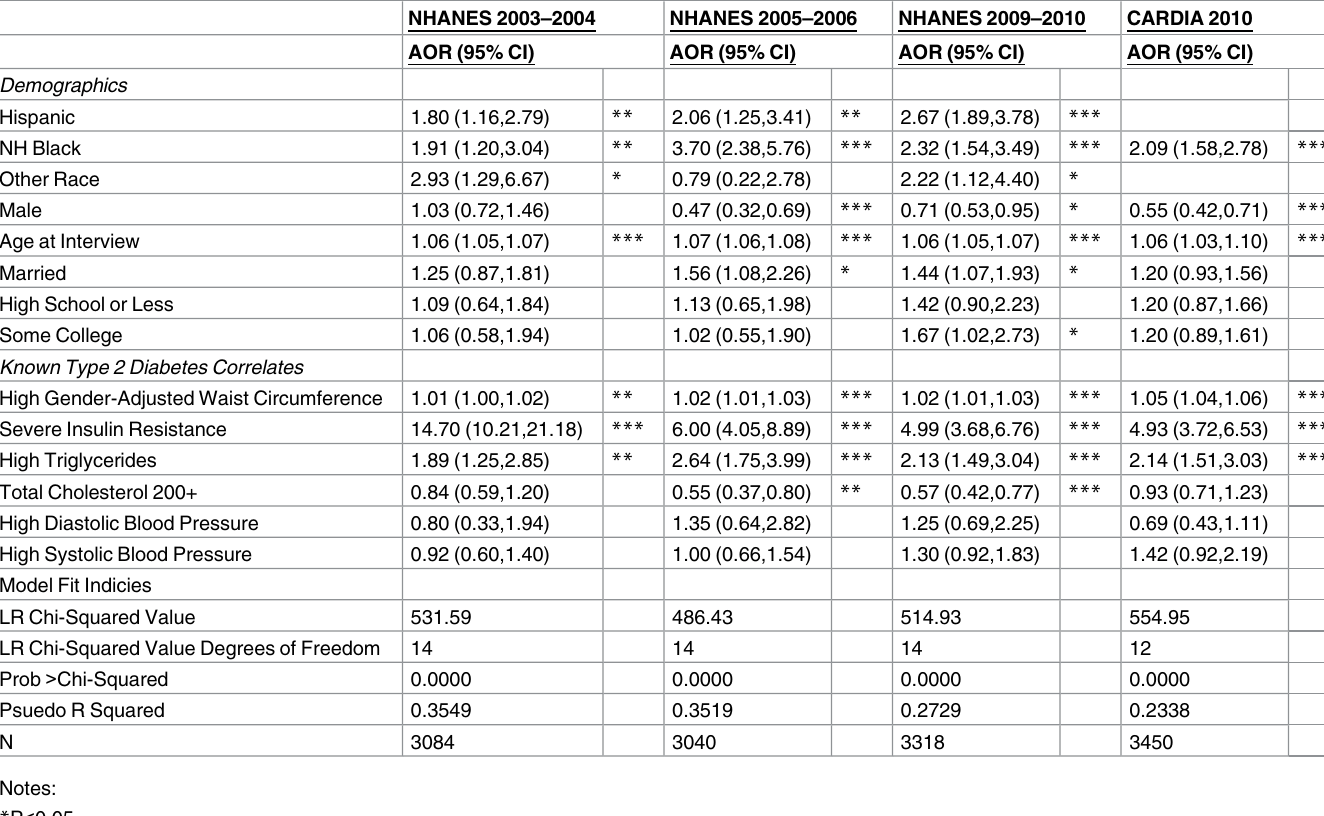
Table 4. Detailed logistic regression predicting model-defined Type 2 Diabetes Mellitus (Class 2) using LCA defined classesof NHANES & CAR- DIA